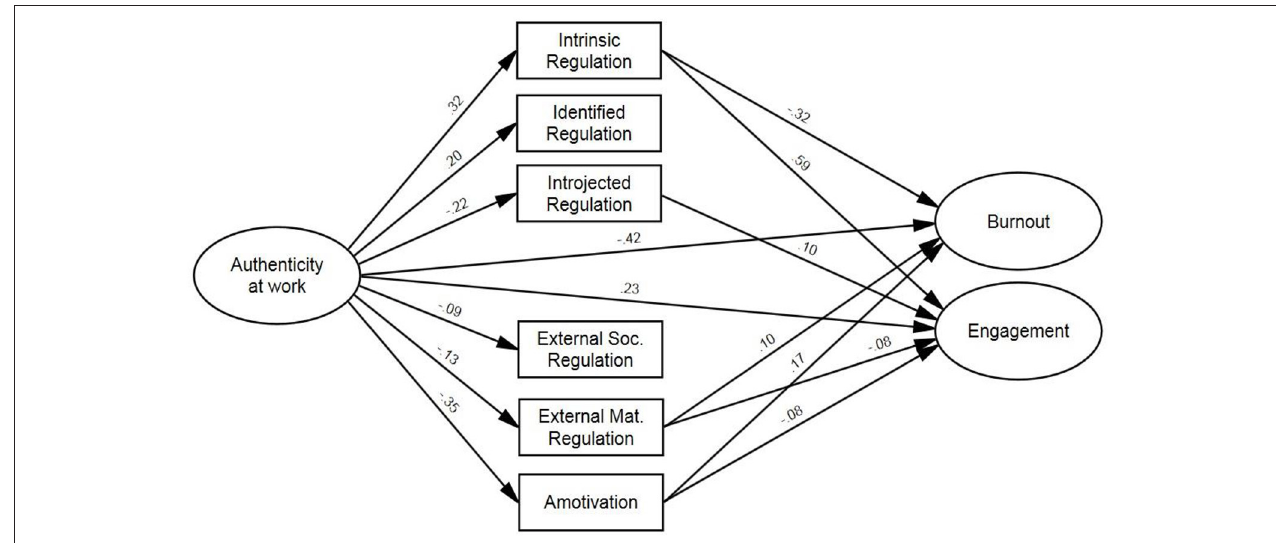
FIGURE 2 | Structural paths of the partial mediation model. Coefficients represent standardized estimates. Non-significant effects are omitted for clarity.